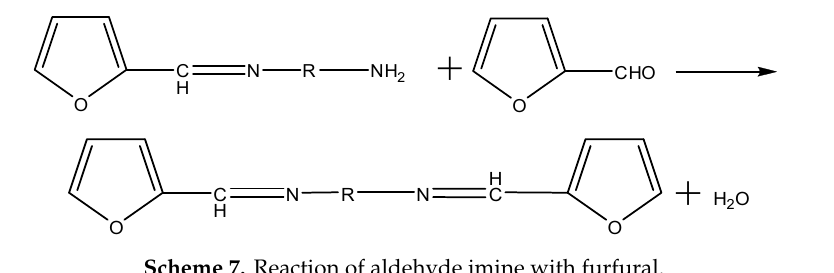
Scheme 7. Reaction of aldehyde imine with furfural.